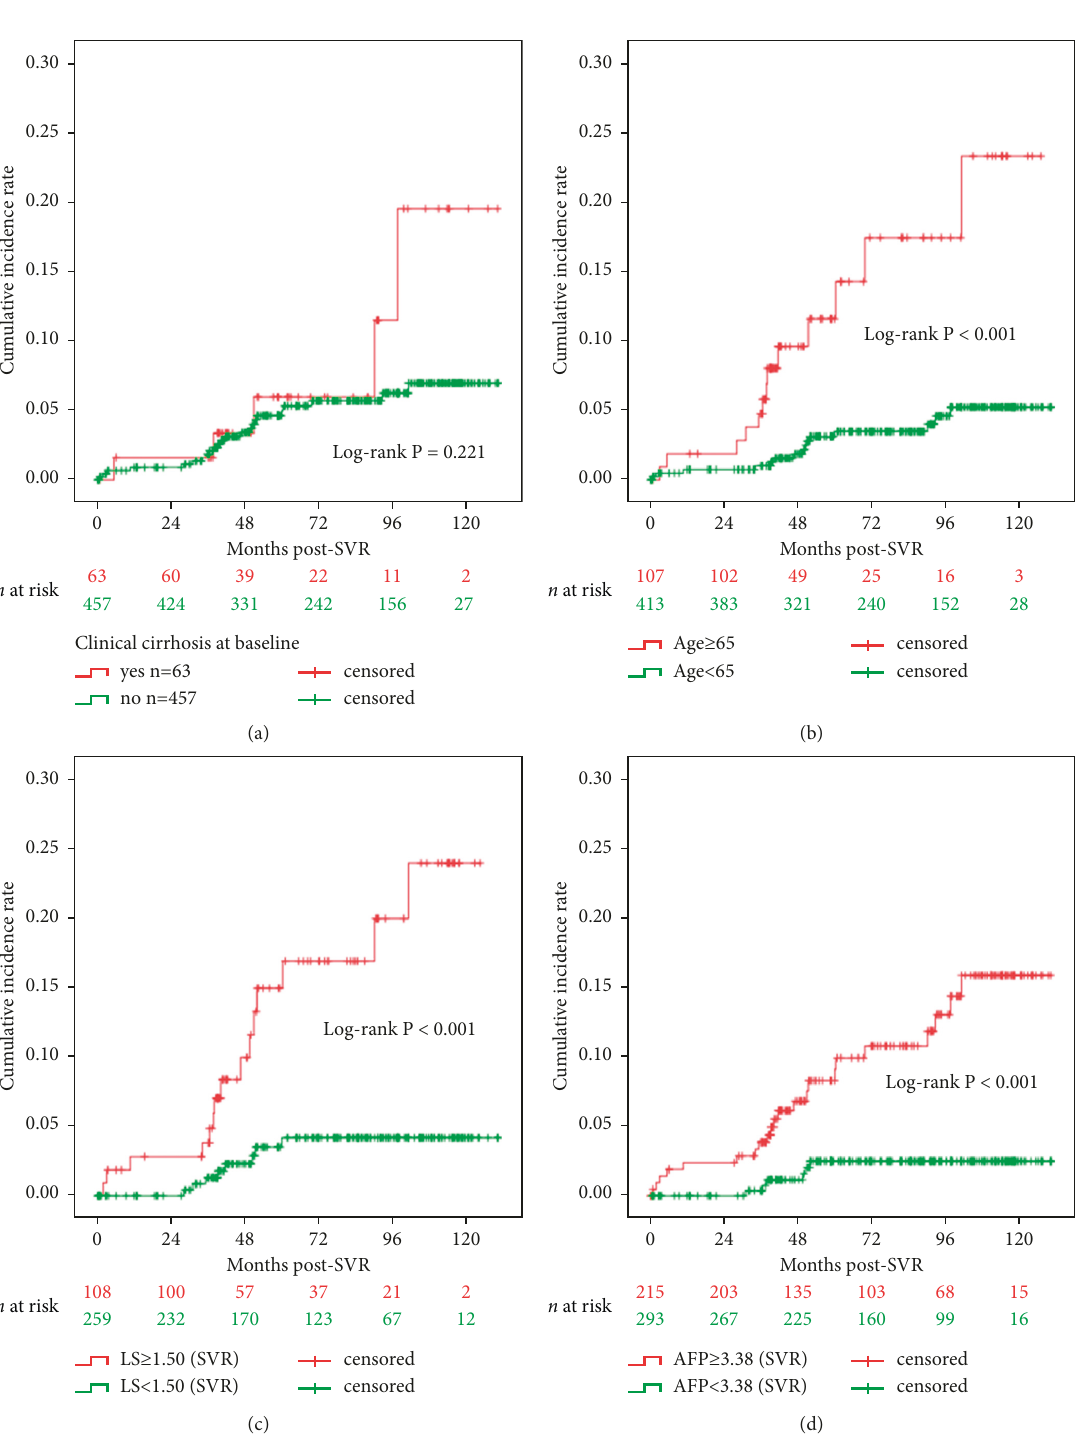
28), stratified by clinical cirrhosis (cid:31) 23), stratified by LS (m/s) (SVR), and (d) LREs ( n 28), stratified by (cid:31) (cid:31)